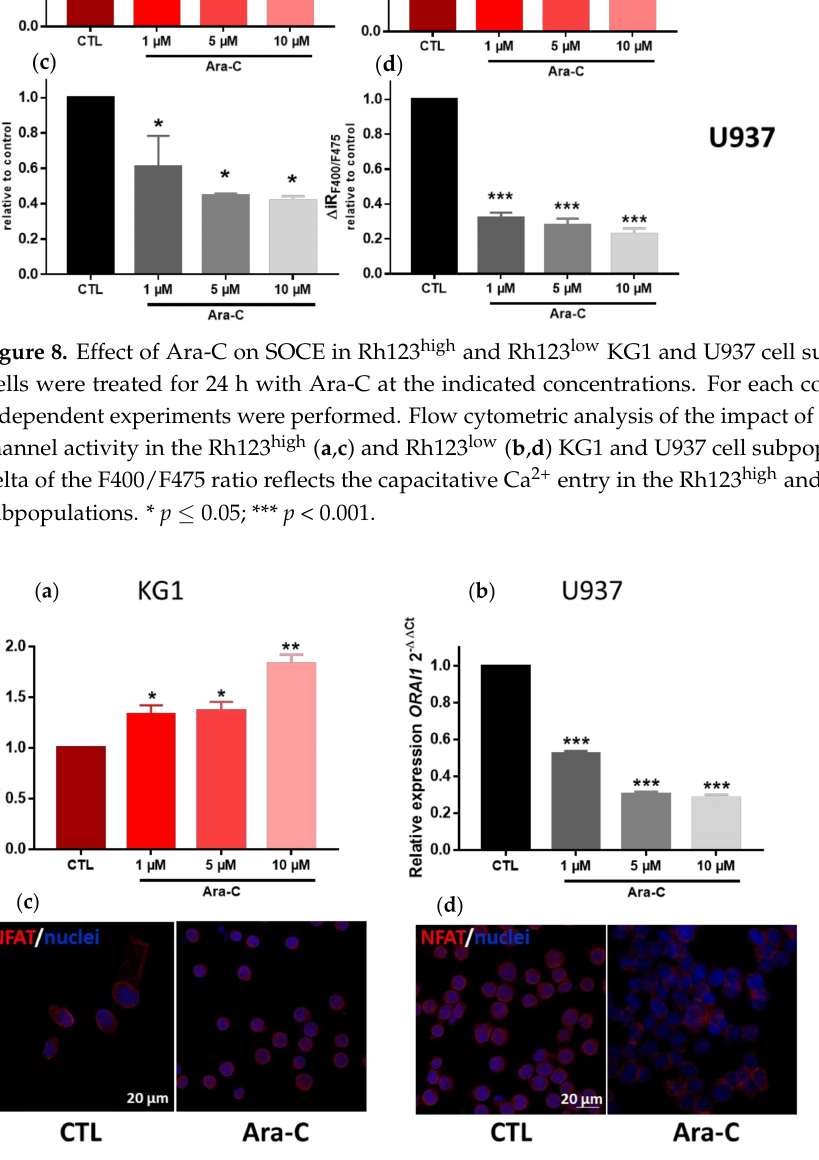
Figure 9. Effect of Ara-C on ORAI1 expression and NFAT localization. Relative expression of the calcium channel ORAI1 in KG1 ( a ) and U937 ( b ) leukemic cell lines. ORAI1 expression was analyzed by RT–qPCR. The relative expression ratio for ORAI1 was calculated by the 2 − ∆∆ Ct method. * p < 0.05; ** p < 0.01; *** p < 0.001. Confocal microscopy showing NFAT expression and localization (Alexa Fluor 488, red) and nuclei (Hoechst, blue) in control and Ara-C-treated (5 µ M) KG1 ( c ) or U937 ( d ) cells. The scale bar is